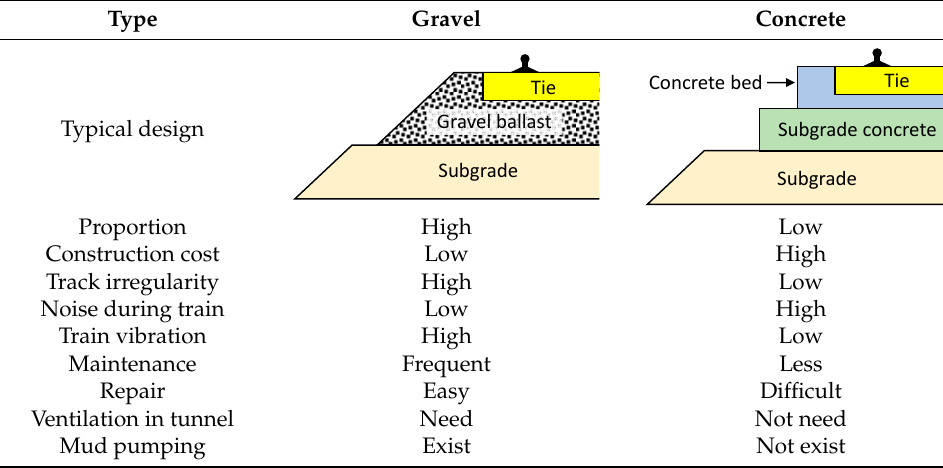
Table 1. Characteristics of gravel and concrete ballasts.